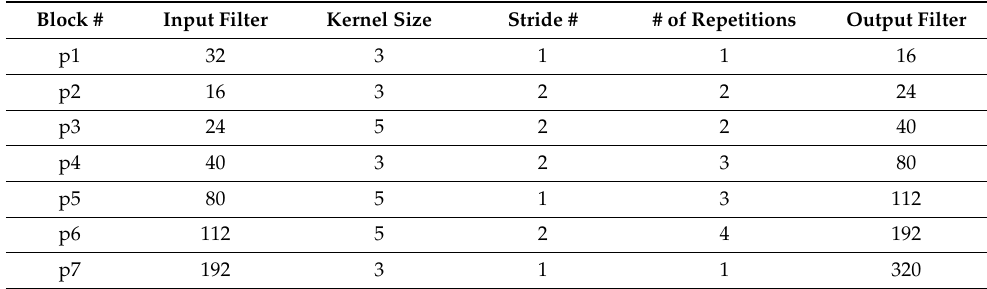
Table 3. EfficientNet-B1 block